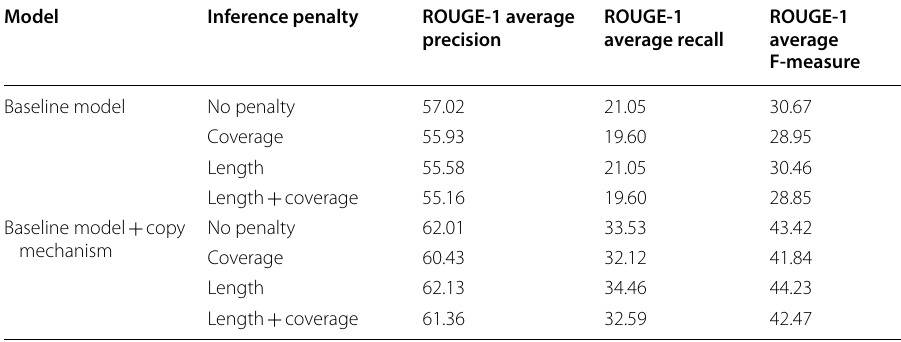
All our ROUGE scores have a 95% confidence interval of at most ±